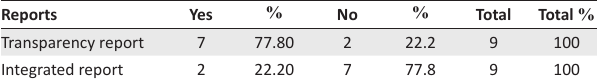
TABLE 1 : Release of transparency or integrated